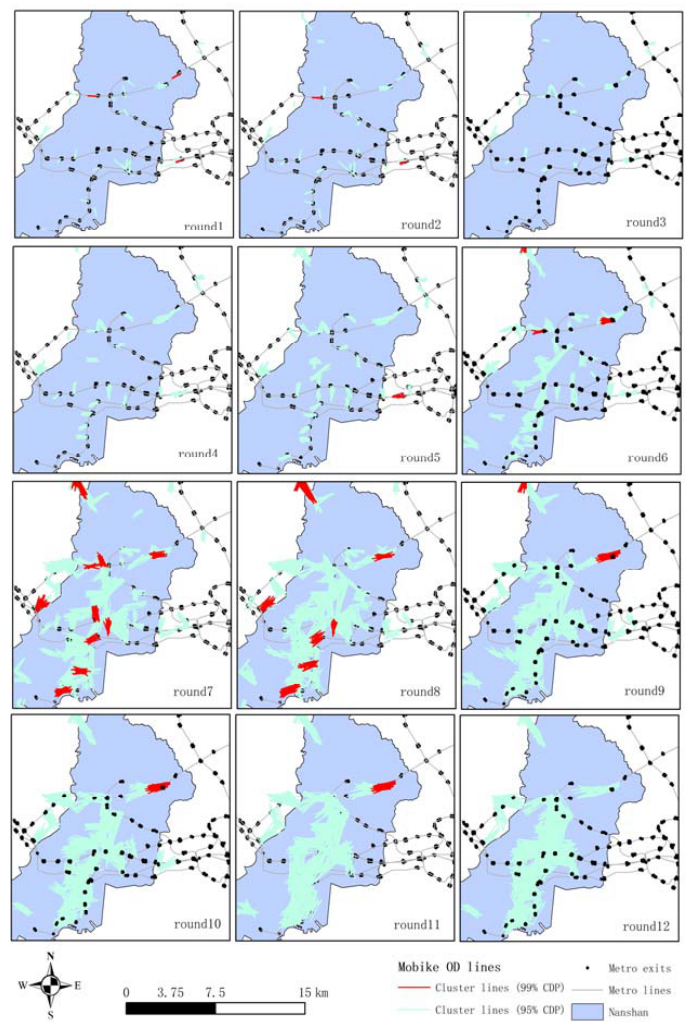
Figure 11. Clustering results for fixed radiuses from round 1 to round 12.